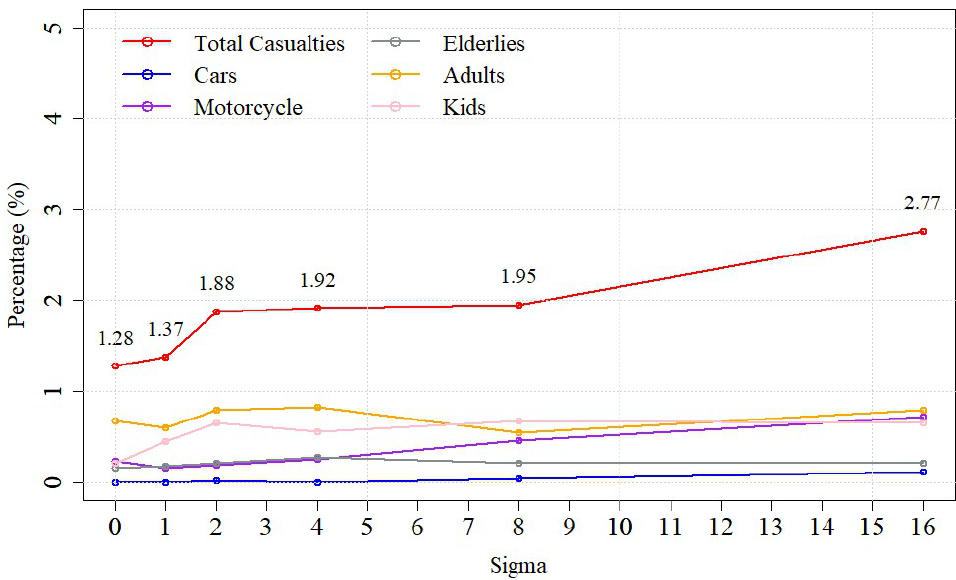
Figure 6. Mortality rate according to the varying scale parameters.